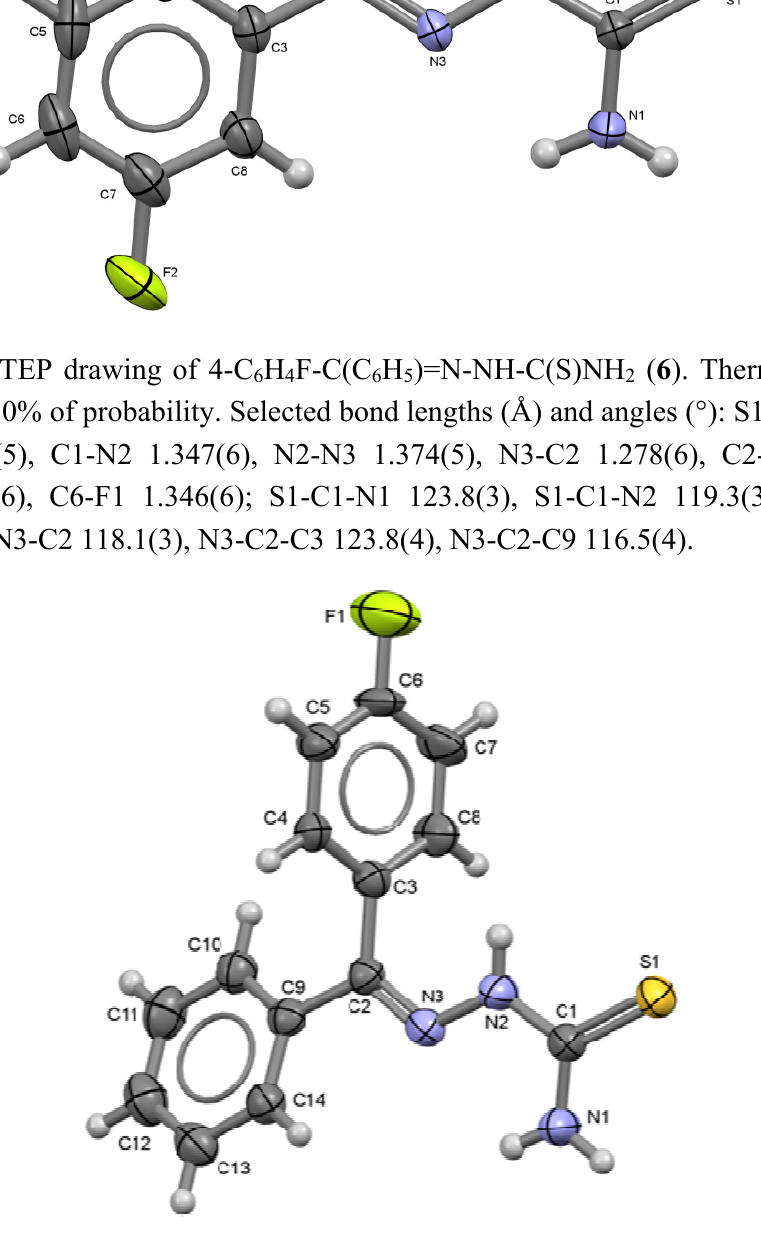
Figure 5. ORTEP drawing of 3,5-C shown at 50% of probability. Selected bond lengths (Å) and angles (°): S1-C1 1.6890(14), C1-N1 1.3164(19), C1-N2 1.3439(19), N2-N3 1.3699(16), N3-C2 1.2769(19), C2-C3 1.464(2), C5-F1 1.357(2), C7-F2 1.357(2); S1-C1-N1 123.19(12), S1-C1-N2 119.64(11),